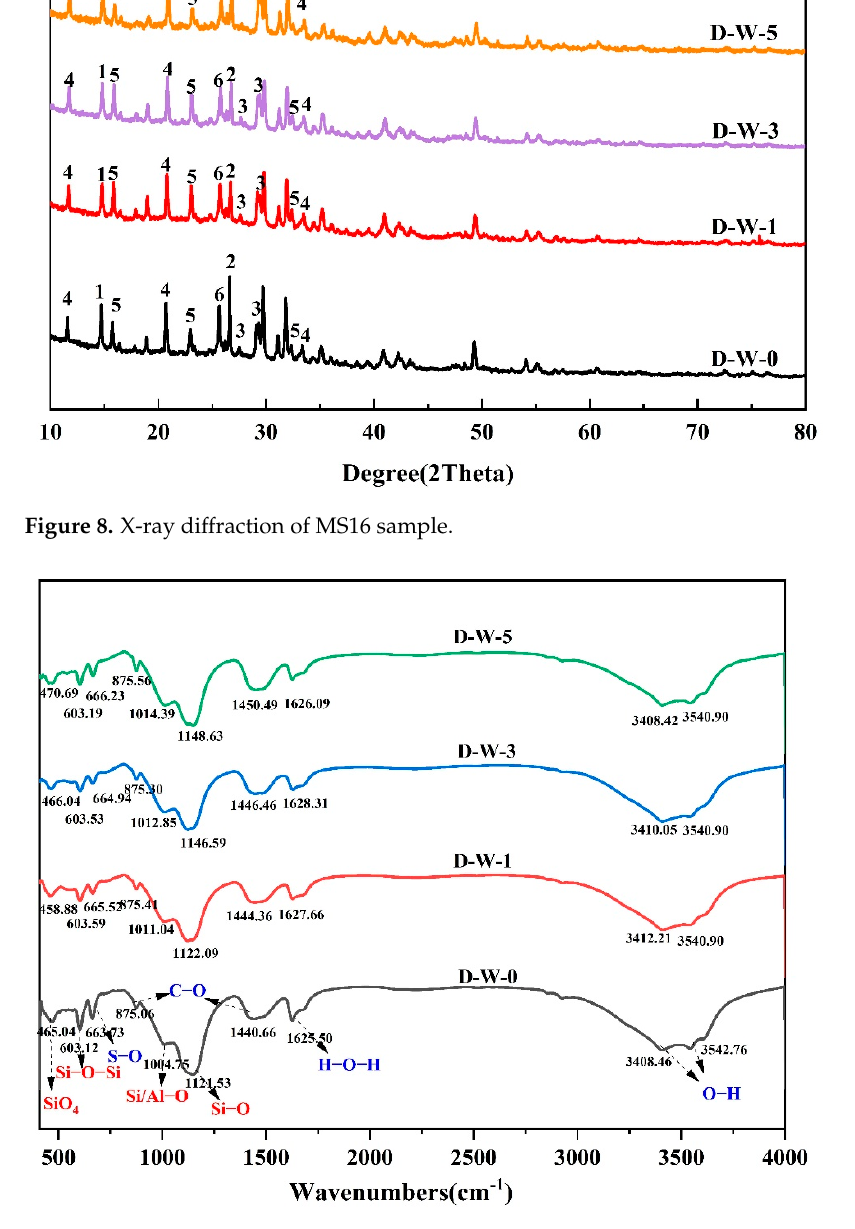
Figure 9. The FT ‐ IR spectra of MS16 sample. Figure 9. The FT-IR spectra of MS16